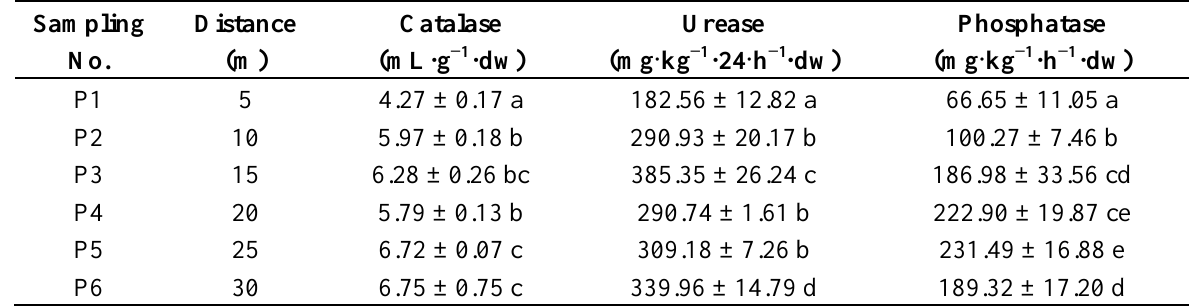
Table 2. Soil enzymes activities in paddy soil in different distances.